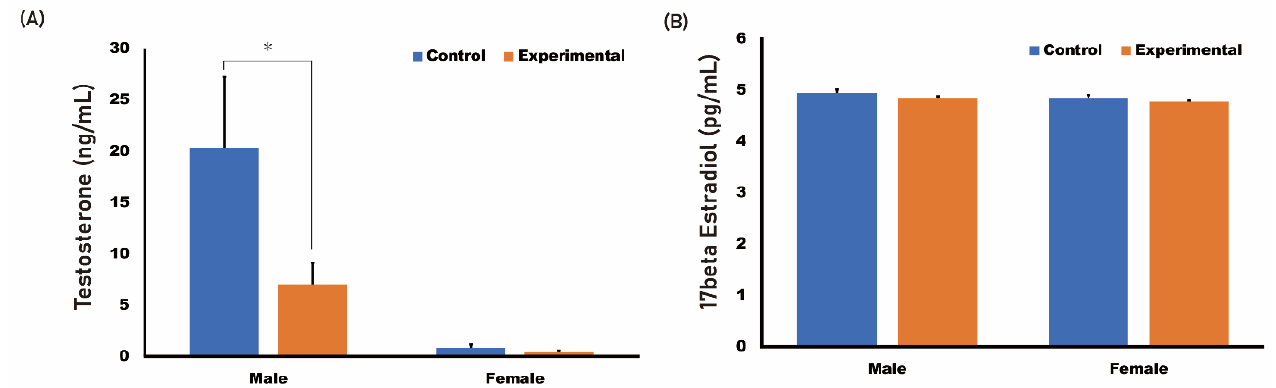
Figure 3. Serum level of sex hormones. Generally, the serum testosterone level was decreased by 4HR administration. ( A ) Serum testosterone level showed a significant difference between male 4HR treated and untreated rats (* p < 0.05). However, there was no difference in the serum testosterone level of female rats. Though the female groups also showed a similar trend, but the difference between groups was statistically insignificant. ( B ) Serum 17 β estradiol level did not show any difference between groups ( p > 0.05).